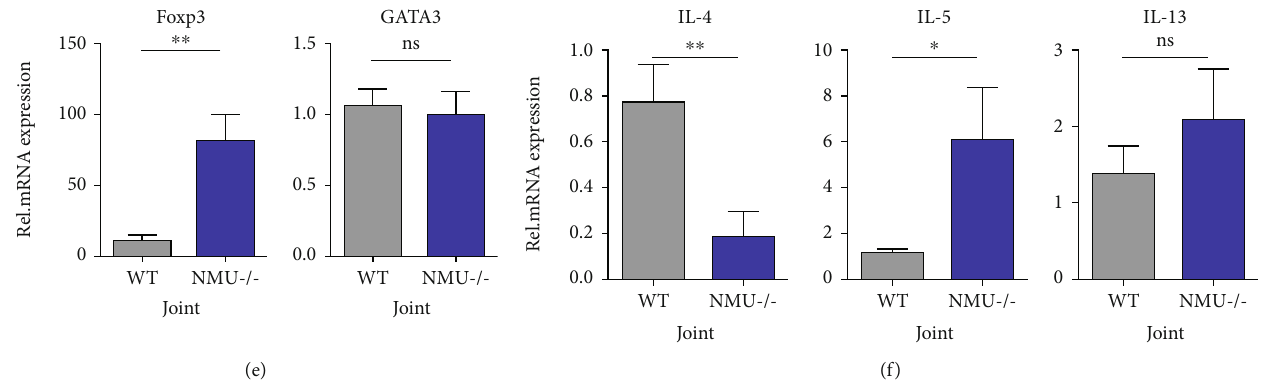
Figure 4: NMU-de fi cient mice developed signi fi cantly less severe arthritis. (a) Clinical assessment of NMU +/+ and NMU -/- CIA mice ( n = 4 each in two independent experiments) determined every 2 days. (b) Quanti fi cation of histological score and number of osteoclasts in the knee joint and hind paw of mice. (c) The frequency of ILC2 in the joint, mLN, and spleen of arthritic mice. (d) The frequency of Treg in the joint, mLN, and spleen of arthritic mice. (e, f) mRNA expression of FoxP3, Gata3 (e), IL-4, IL-5, and IL-13 (f) in the joint of WT and NMU -/- mice. Data are shown as mean ± SEM ( ∗ P < 0 : 05 and ∗∗ P < 0 : 01 determined by Student ’ s t -test).